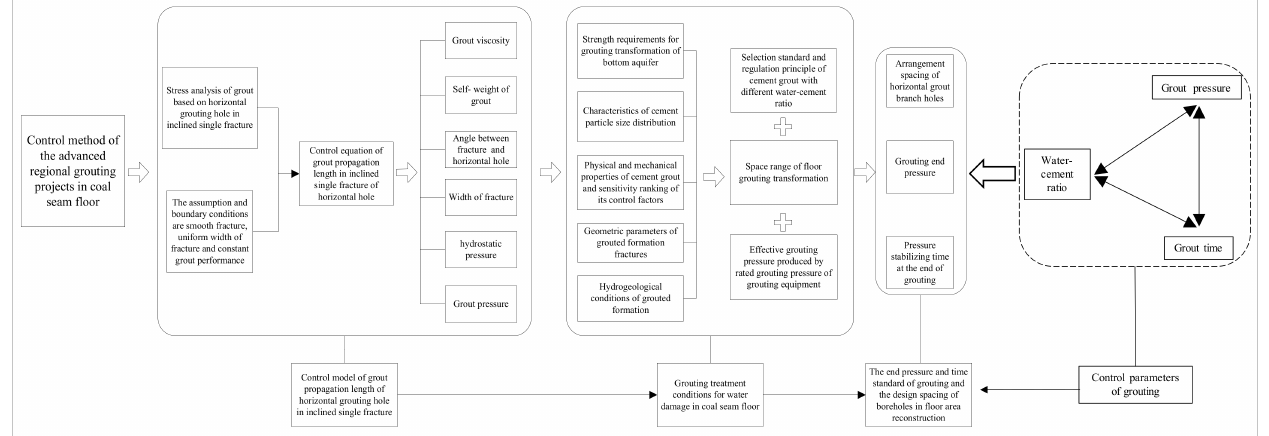
Figure 13. Technical route of grout propagation control method for advanced regional grouting projects in coal